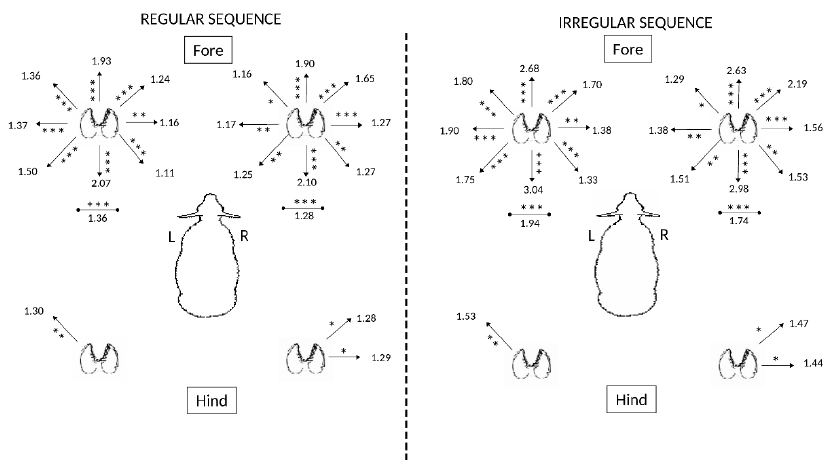
Animals 2019 , 9 , x FOR PEER REVIEW 10 of 21 Stepping responses to the different types of movement (pitch, roll and the combined roll and pitch floor motion) were greatest for the combined motion (Figure 3). The increased stepping for each Figure 2. E ff ects of regularity of movement of the floor on movements (steps / 20 min) of the four Figure 2. Effects of regularity of movement of the floor on movements (steps/20 min) of the four limbs individual leg was predominantly on a diagonal orientation from left caudal to right rostral, of sheep ( n = 6). Directions for significant differences in stepping frequency observed for each limbs of sheep ( n = 6). Directions for significant di ff erences in stepping frequency observed for each including stepping within the rostro-caudal direction and, in the forelimbs, also lateral stepping respective limb are presented (* p < 0.05; ** p < 0.02; *** p < 0.001). respective limb are presented (* p < 0.05; ** p < 0.02; *** p < 0.001). movements to the left (Figure 3). Tabulated results are presented in Appendix A, Table A3.